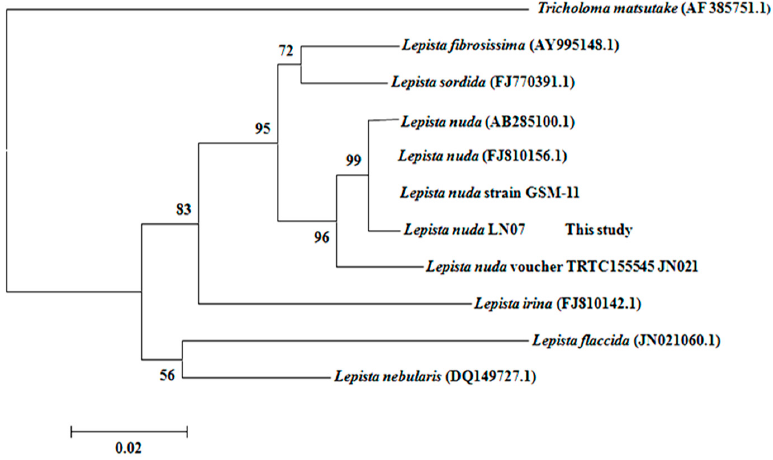
Figure 1. Polymeric analysis of strain LN07 and other tricholomataceae species based on ITS sequences.